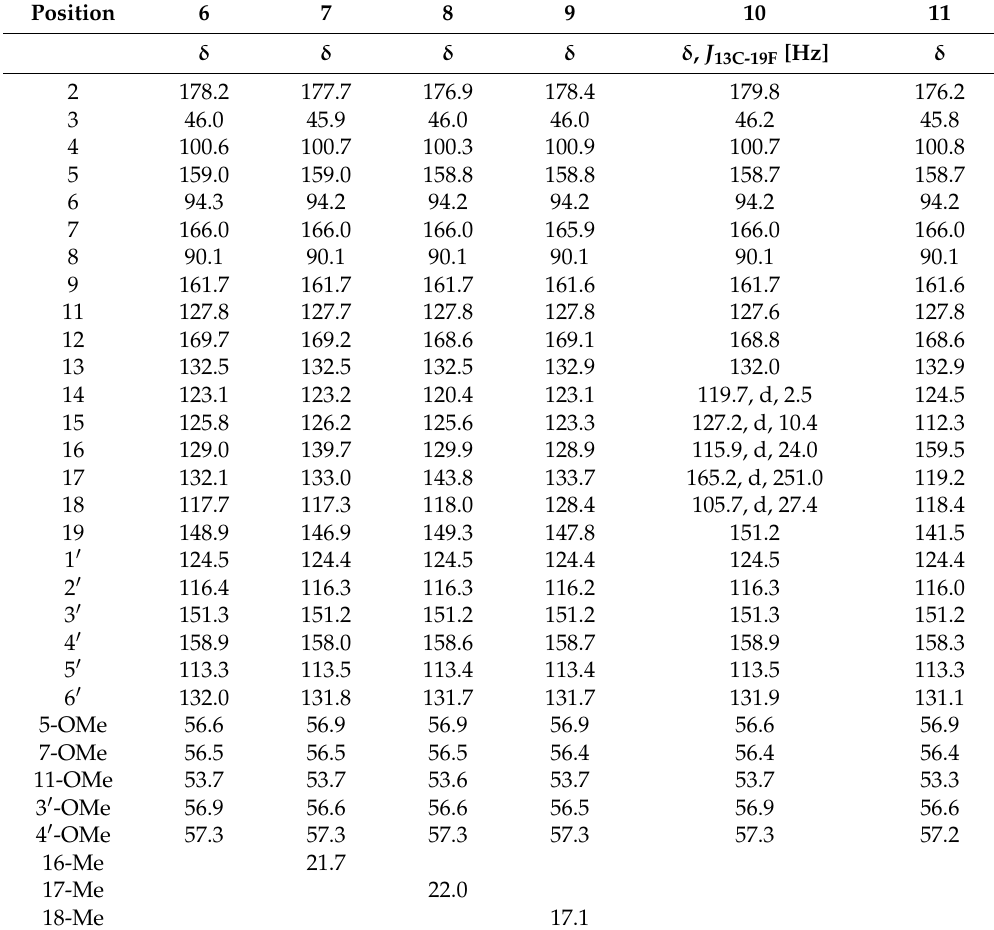
Table 2. 13 C-NMR data of nudicaulin derivatives 6 to 11 (125 MHz, MeOH- d 4 /1%